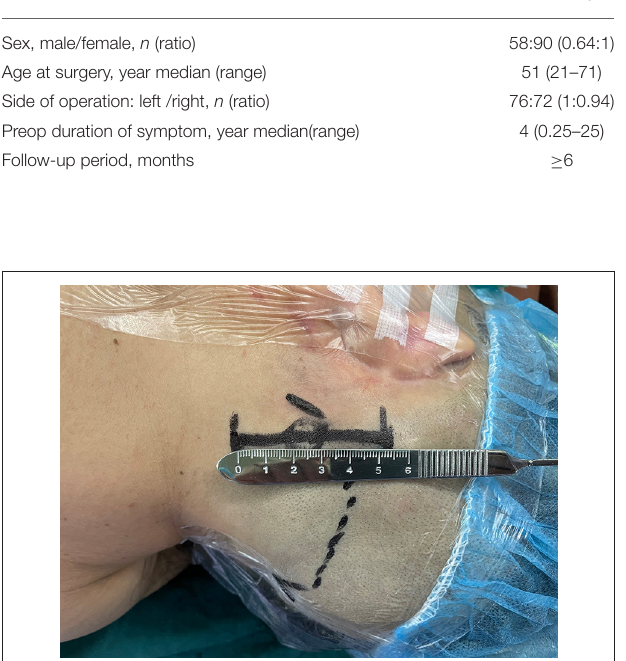
FIGURE 1 | Skin incision in the retroauricular region, with a length of about 5